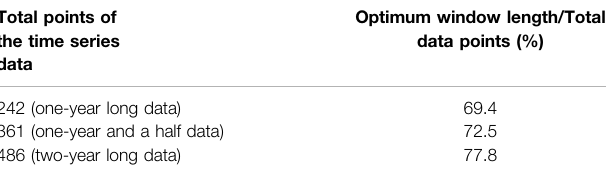
TABLE 2 | Optimum window length for constructing network through SVG for stock opening price of Ping An Bank Co. with different total data points. Total points of the time